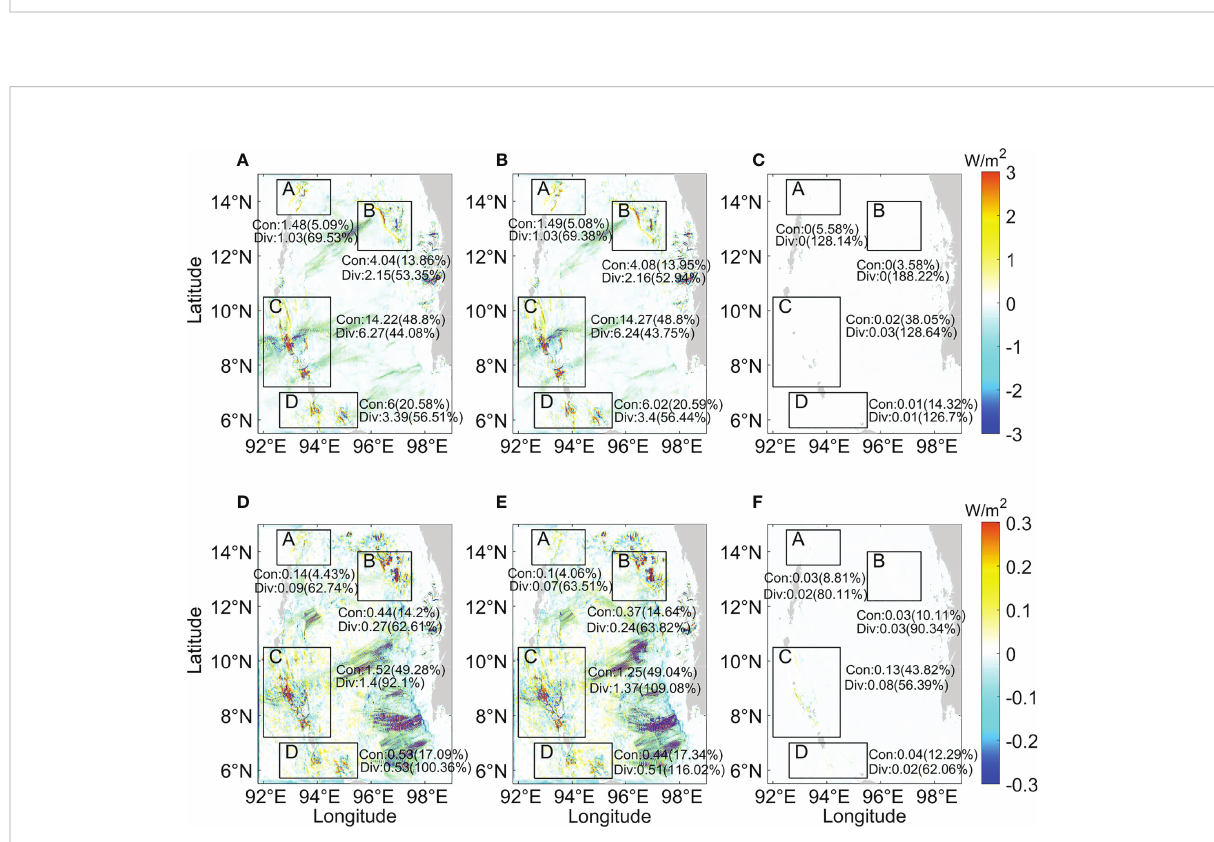
FIGURE 14 Spatial distribution of the time-averaged depth-integrated baroclinic energy fl ux divergence in the (A, D) Experiment 1, (B, E) Experiment 2, and (C, F) Experiment 3. The period of (A – C) is spring tide, and the range of color scale is – 3~3W/m 2 ; the period of (D – F) is neap tide, and the range of color scale is – 0.3~0.3W/m 2 . The four rectangles present the main generation subdomains of internal tides. Con represents the barotropic-to-baroclinic energy conversion rate of the corresponding subdomain (unit: GW), and the percentage of that to the total barotropic- to-baroclinic energy conversion rate in the Andaman Sea is shown in brackets. Div represents the baroclinic energy fl ux divergence of the corresponding subdomain (unit: GW), and the percentage of that to the barotropic-to-baroclinic energy conversion rate of the corresponding subdomain is shown in brackets.